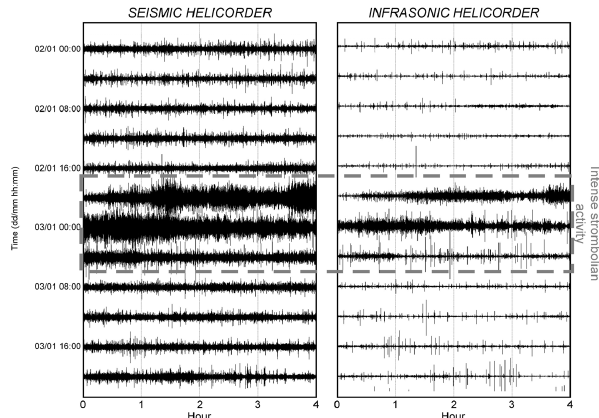
Fig. 3. Helicorder plots of seismic and infrasonic signals recorded from 2 to 3 January 2011 at EBEL station. The grey dashed rectan- gle indicates the time interval characterised by intense strombolian activity.